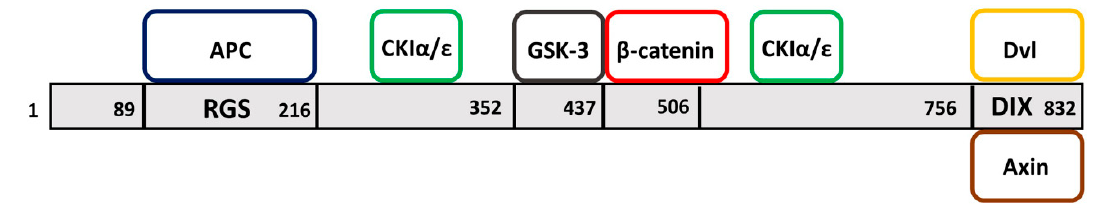
Figure 2. Axin binds to a wide array of proteins. Shown here are the WNT signaling components—APC, CKI, GSK-3, β -catenin and Dvl, with known relative binding positions in Mouse Axin1 (NP_001153070.1). The C-terminus domain (DIX) facilitates formation of homo and hetero dimers.